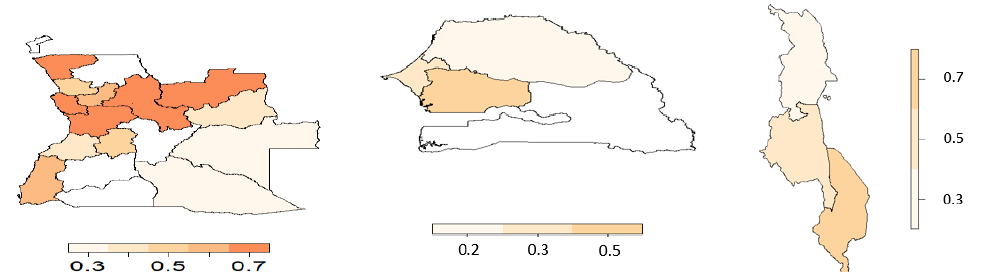
Figure 7. Joint probability of a child being not malnourished and not anaemic. ( Left ) Angola, ( middle ) Senegal, and ( right ) Malawi.